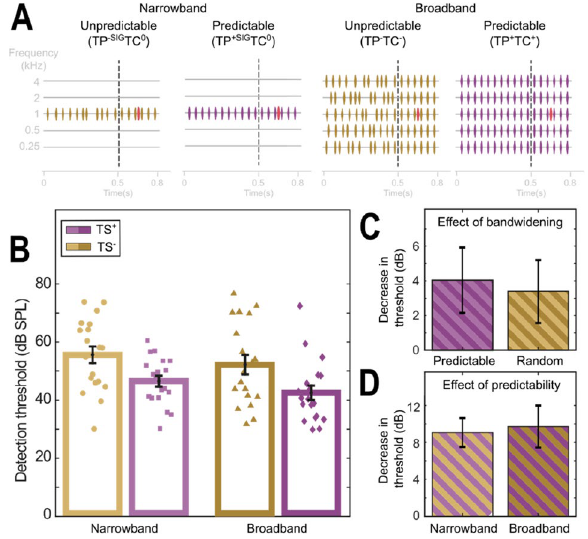
Figure 1. Temporal coherence and temporal predictability during build-up significantly affect subsequent detectability, when the two cues are not in conflict there is no evidence of an interaction. ( A ) Stimulus schematic. Each stimulus was composed of a background (purple/gold) and a pure tone signal (red). The backgrounds were a series of pure tone pips presented in either: (i) Left two panels) a narrowband (TC 0 notation) or (ii) Right two panels) broadband (TP +/− notation, 5 × 1 octave spaced tones centred at 1 kHz) configuration. Each background was composed of a pre-cursor (left of the vertical dashed line) and a masker (right of the vertical dashed line). The pre-cursor could either promote temporal predictability (purple and TP + notations, including TP +SIG ) or disrupt temporal predictability (gold and TP − notation, including TP −SIG ). ( B ) Pure-tone detection thresholds for each condition in ( A ). The effect of bandwidening ( C , in the predictable vs jittered conditions) and temporal predictability ( D , in the narrowband vs broadband conditions) to detection thresholds. ( C ) The reduction in masking attributable to bandwidening was similar across the two temporal predictability conditions (Predictable = TP +SIG TC 0 vs TP +SIG TC 0 and Jittered = TP − SIG TC 0 vs TP - TC - , Predictable = ~ 4 dB, Jittered = ~ 3.4 dB). ( D ) The reduction in masking attributable to adding temporal predictability (in the precursor) was also similar (Narrowband = TP +SIG TC 0 vs TP −SIG TC 0 and Broadband = TP + TC + vs TP − TC − , Narrowband: ~ 9.1 dB, Broadband: ~ 9.7